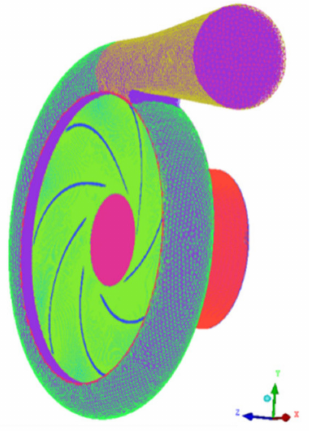
Figure 2. Simulation domain of the mesh